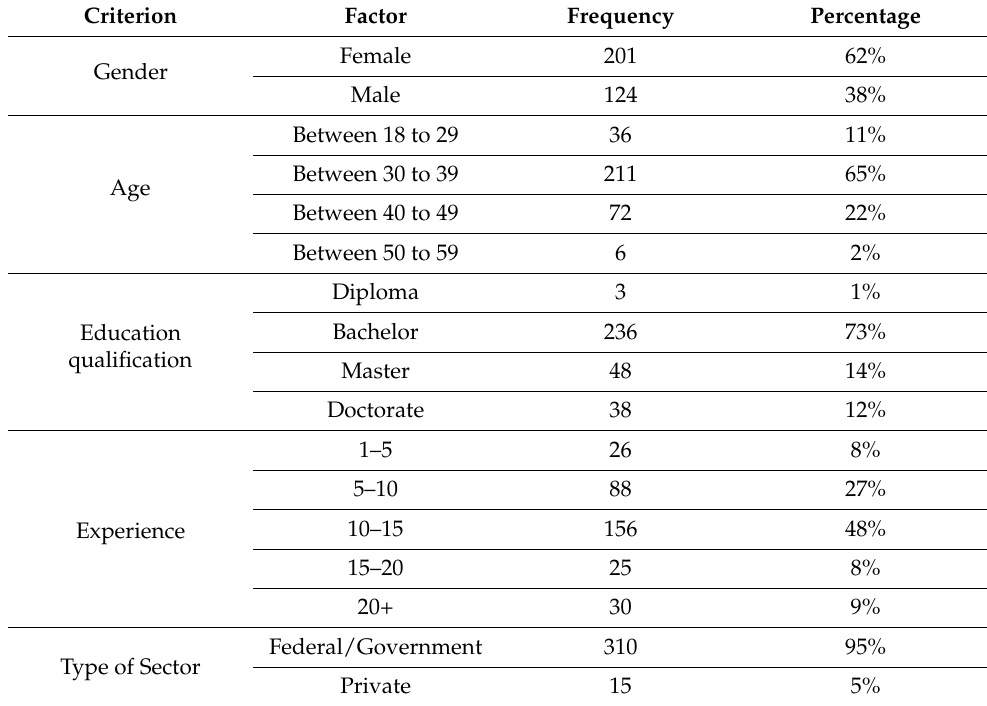
Table 2. Demographic data of the respondents.